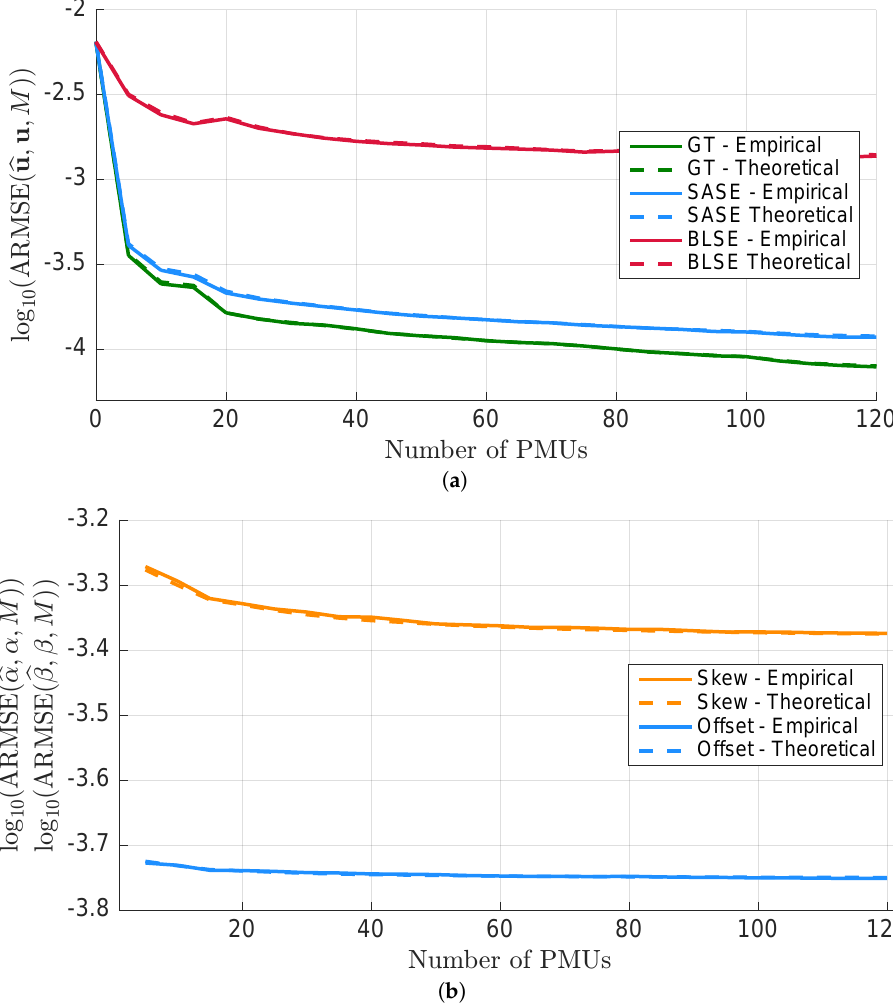
(cid:92) Figure 4. Empirical ARMSE (17) and theoretical ARMSE (18) for the voltage ( a ) and delay parameters ( b ) as function of the number of the installed PMUs for M = 30. All values are in logarithmic